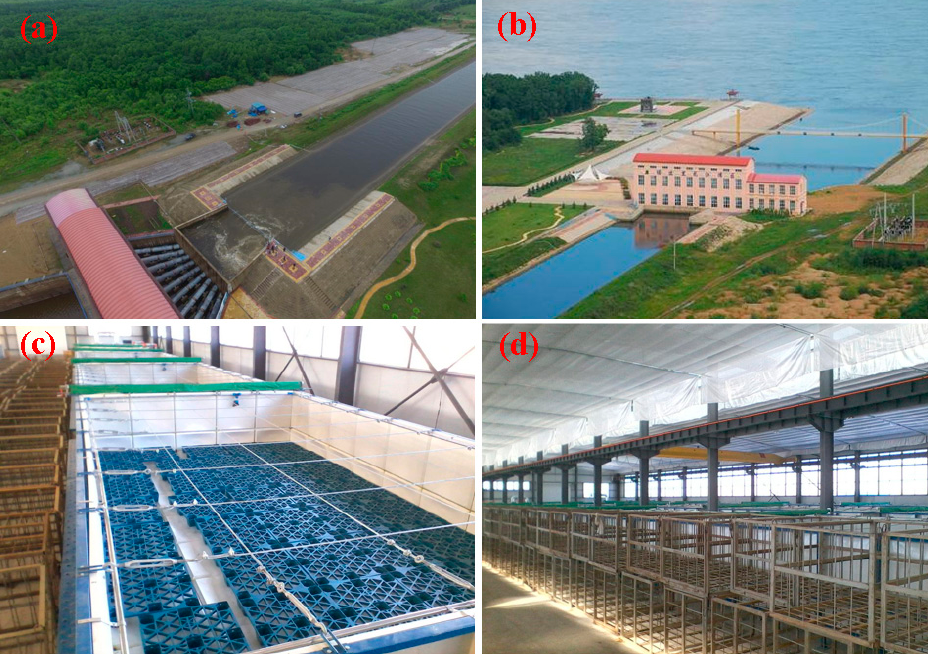
Figure 12. ( a , b ) Irrigation project; ( c , d ) advanced germination and soaking facilities.